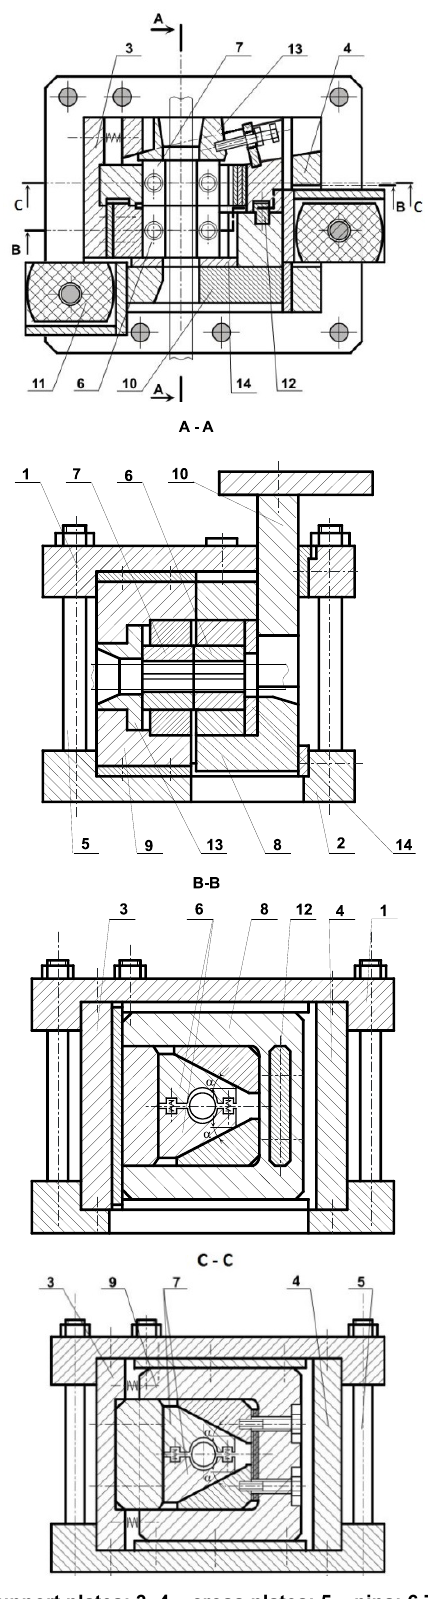
Figure 1. A stamp of the basic design for rolled stock cutting by shear with a differentiated